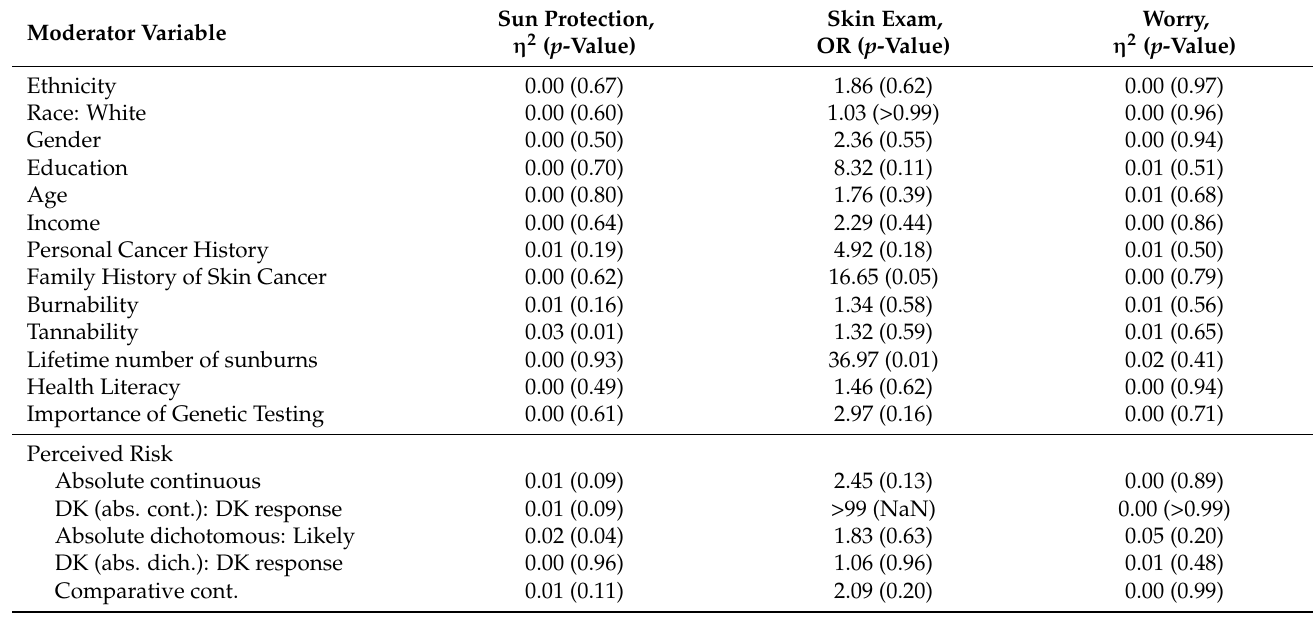
Table 4. Effect sizes for moderator effects of risk results (higher vs. average) on sun protection, skin exam, and